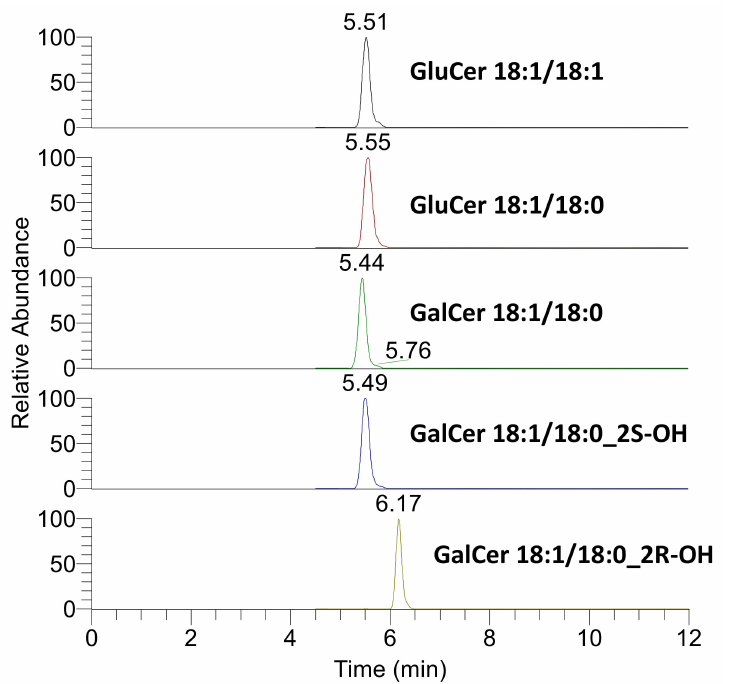
Figure 6. Chromatograms of five synthetic Crb standards characterized by di ff erent fatty acyl chains, di ff erent monosaccharide head groups and di ff erent stereochemistries.